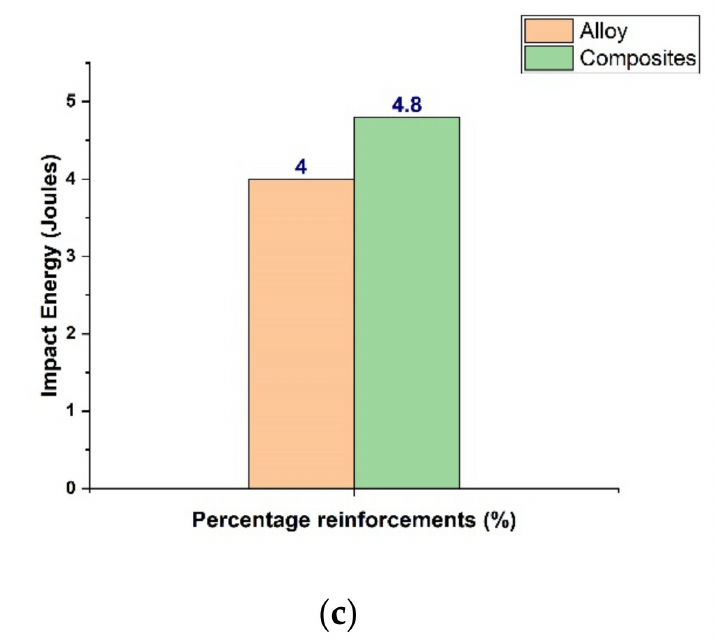
Figure 8. ( a ) Tensile strength (MPa), ( b ) hardness (HRB) and ( c ) impact energy (joules) of the fabricated samples (Al-Mg-0.6Si-0.35Fe alloy without any reinforcing particulates, and Al-Mg-0.6Si- 0.35Fe/15%RHA/5%Cu hybrid composites).